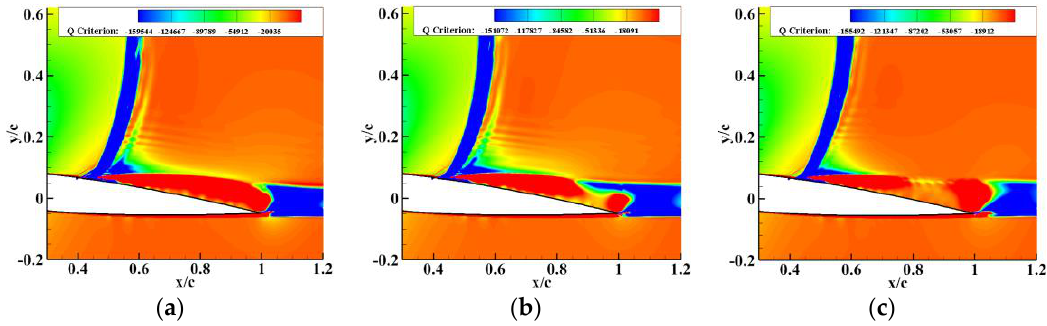
Figure 23. Q-criterion results for the “ 41% x/c ” case. ( a ) Maximum lift; ( b ) median lift; and ( c ) minimum lift.